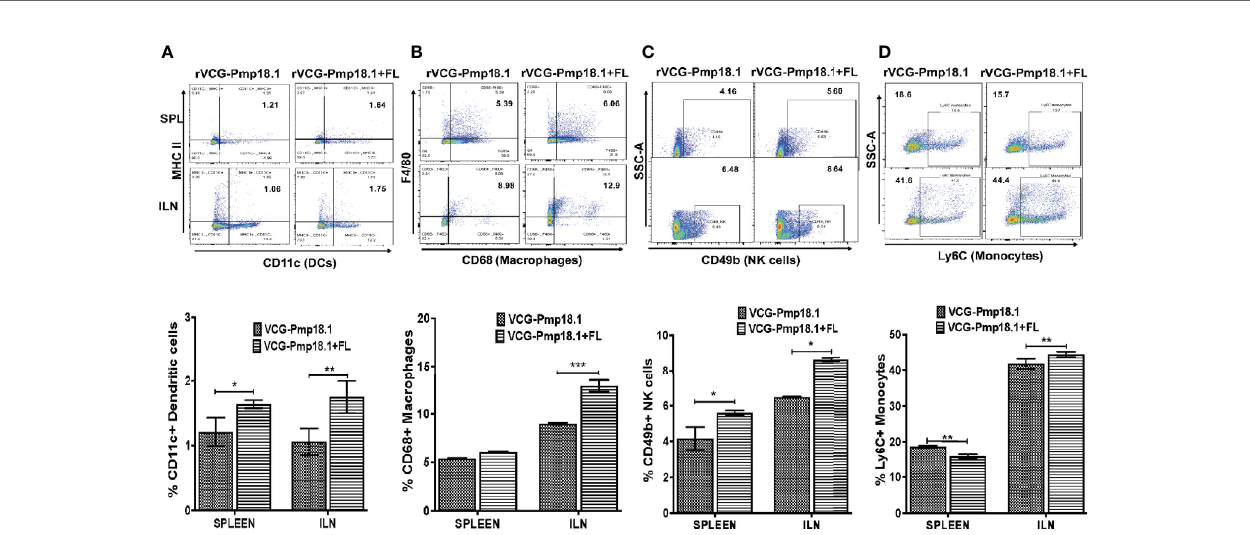
FIGURE 5 | Enhanced mobilization of innate immune cells to mucosal and systemic tissues following immunization of mice with FL adjuvanted rVCG-Pmp18.1 vaccine. Groups of mice (5/group) were immunized three times IN at 2-week intervals. Four weeks postimmunization, single cell suspensions were isolated from harvested spleens and ILN and labeled for 30min at 4°C with fl uorophore-conjugated antibodies. Immune cell phenotypes and numbers were characterized by fl ow cytometry. Representative fl ow cytometric images (top) and bar graphs (bottom) showing percentages of dendritic cells (A) , macrophages (B) , NK cells (C) and monocytes (D) in fi ltrating the spleen and ILN after immunization. The results are shown as mean ± SD and represent two independent experiments ( fi ve mice in each group) with similar results. * p < 0.05, ** p < 0.01, *** p <